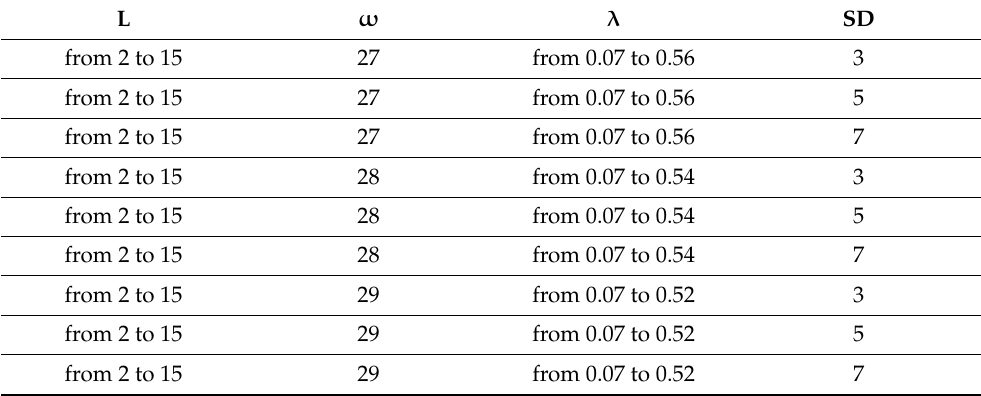
Table 3. Different scenarios on Arena